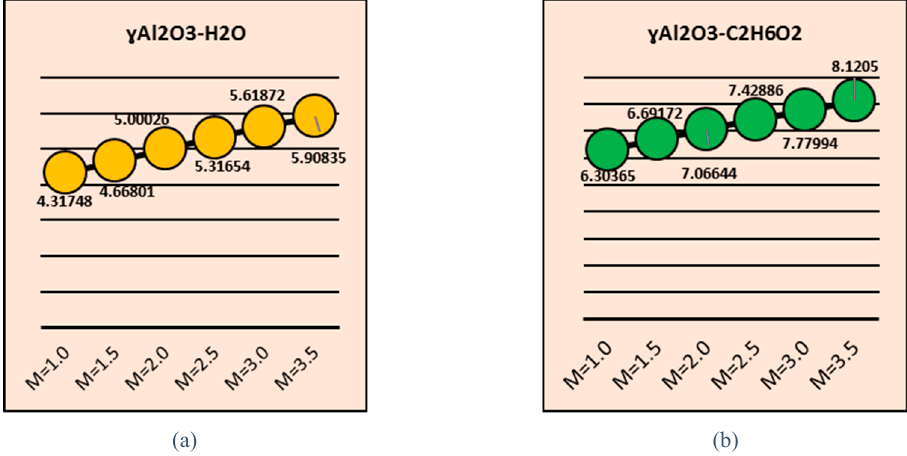
Figure 16. E ff ects of M on the coe ffi cient of skin friction ( a ) γ Al 2 O 3 -H 2 O and ( b ) γ Al 2 O 3 -C 2 H 6 O 2 Figure 16. Effects of 𝑀 on the coefficient of skin friction ( a ) γAl (cid:2870) O (cid:2871) − H (cid:2870) O and ( b ) γAl (cid:2870) O (cid:2871) − C (cid:2870) H (cid:2874) O (cid:2870) Figure 16. Effects of 𝑀 on the coefficient of skin friction ( a ) γAl (cid:2870) O (cid:2871) − H (cid:2870) O and ( b ) γAl (cid:2870) O (cid:2871) − C (cid:2870) H (cid:2874) O (cid:2870)